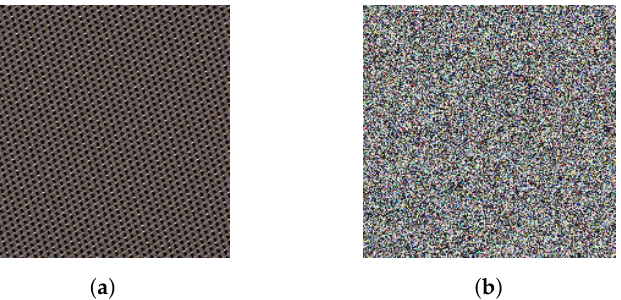
Figure 11. Results of the permutation and diffusion processes. The input of the diffusion process is the result of the permutation stage. As can be seen, the shape of the iris is no longer presented. ( a ) Image permuted with seven iterations using Arnold’s map. ( b ) Image permuted ciphered using Lorenz’ attractor.